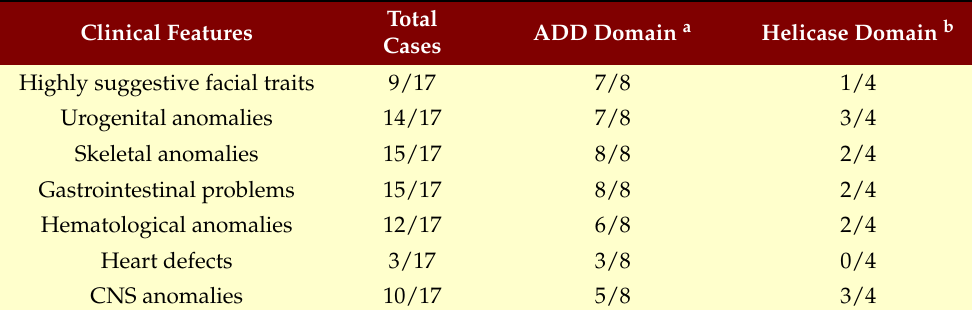
Table 2. Frequency of total and domain-specific clinical